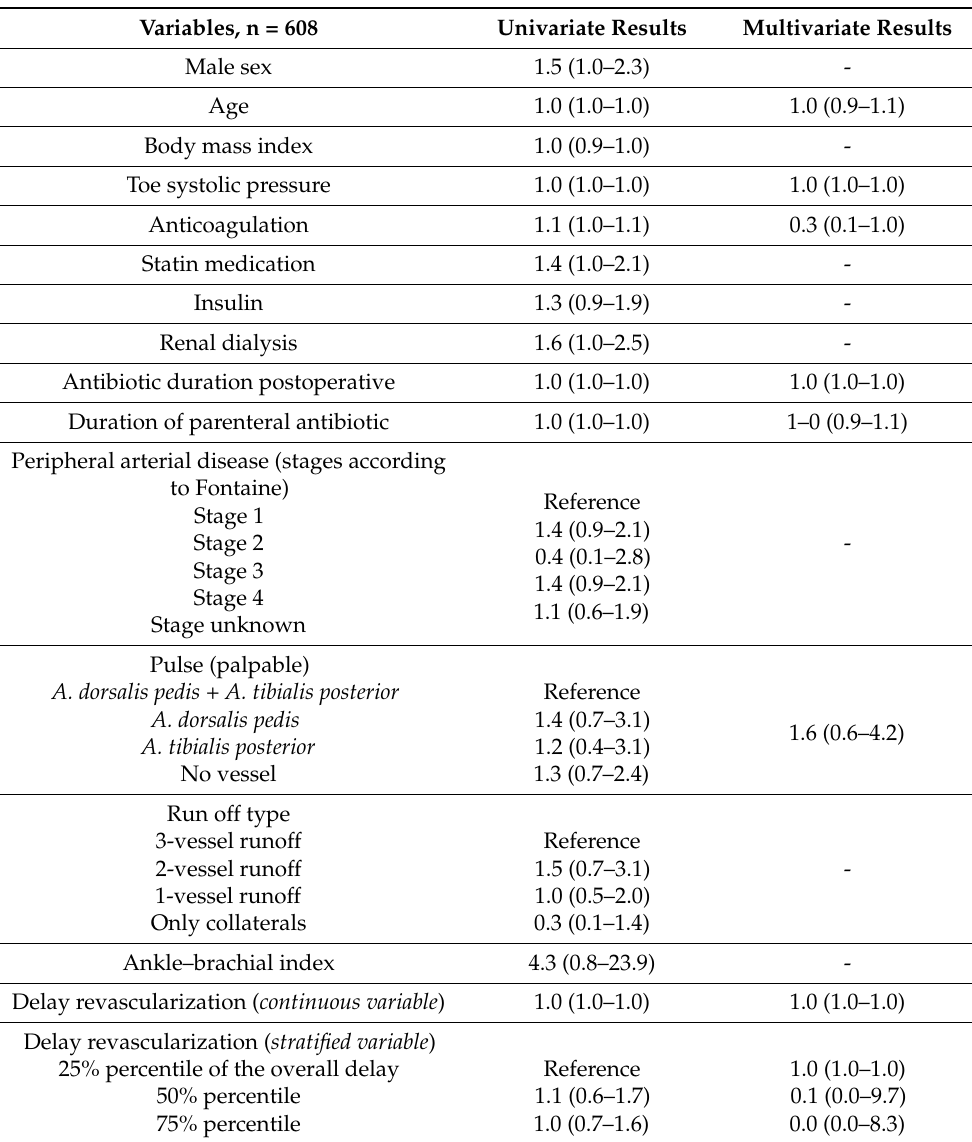
Table 3. Cox regression analysis of factors potentially associated with the outcome “clinical failure” (results expressed as hazard ratio with the corresponding 95% confidence